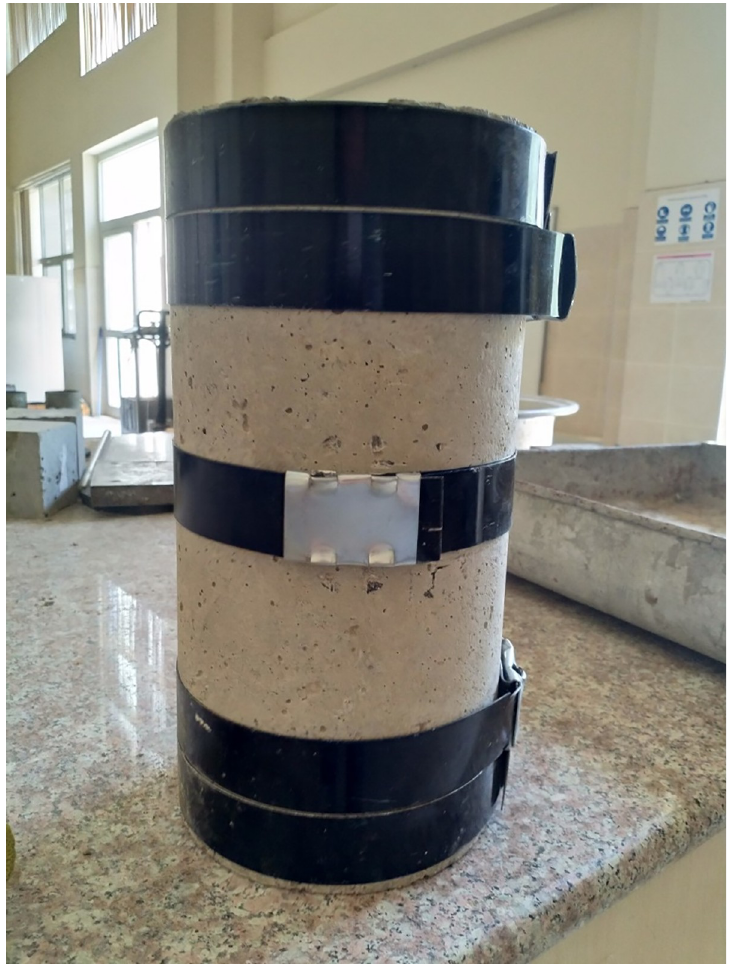
Fig 2. Metal strap and a